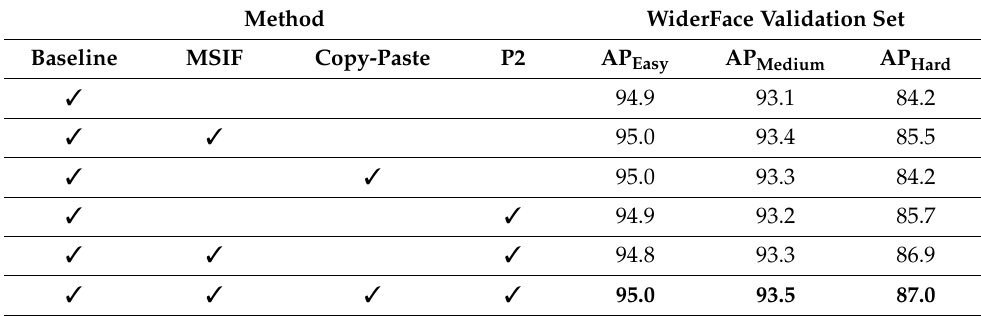
Table 2. Ablation study for the proposed methods with WiderFace validation dataset.